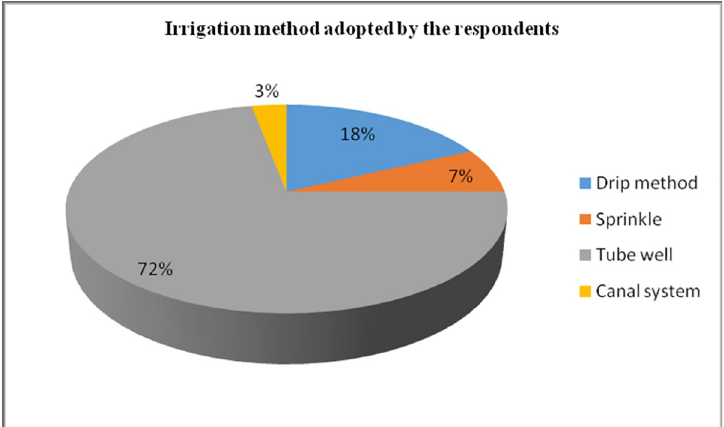
Fig 3. Irrigation method adopted by the respondents. Irrigation method-This pie chart represent the irrigation method adopted by the respondents.72% of the respondents use tube well system for irrigation purpose, 18% use drip method, 7% use sprinkle method and 3% use canal system for irrigation of their